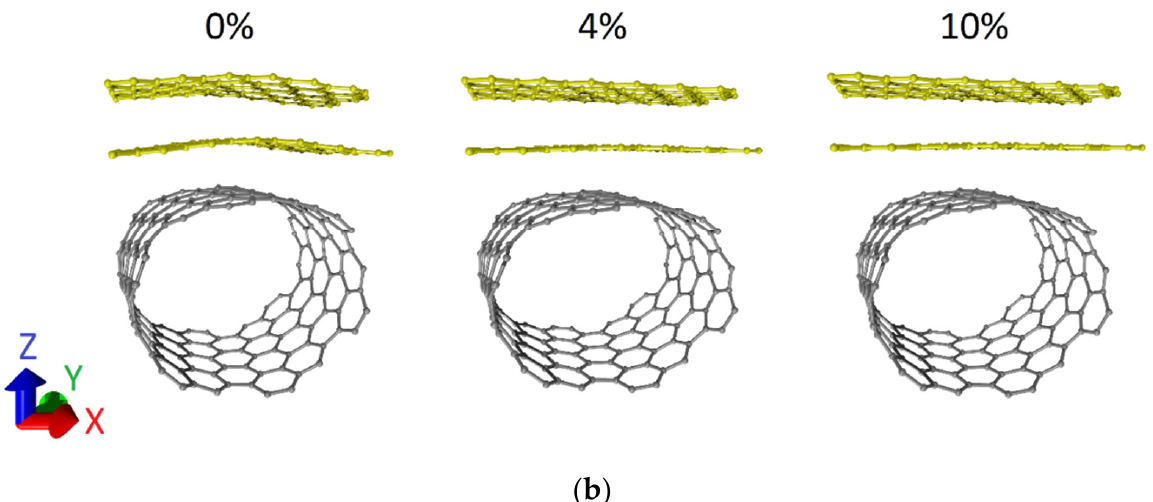
Figure 3. Atomic configurations of supercells of bilayer graphene-SWCNT (12,6) hybrid films with island topology at various values of axial stretching deformation: ( a ) model V1; ( b ) model V2.